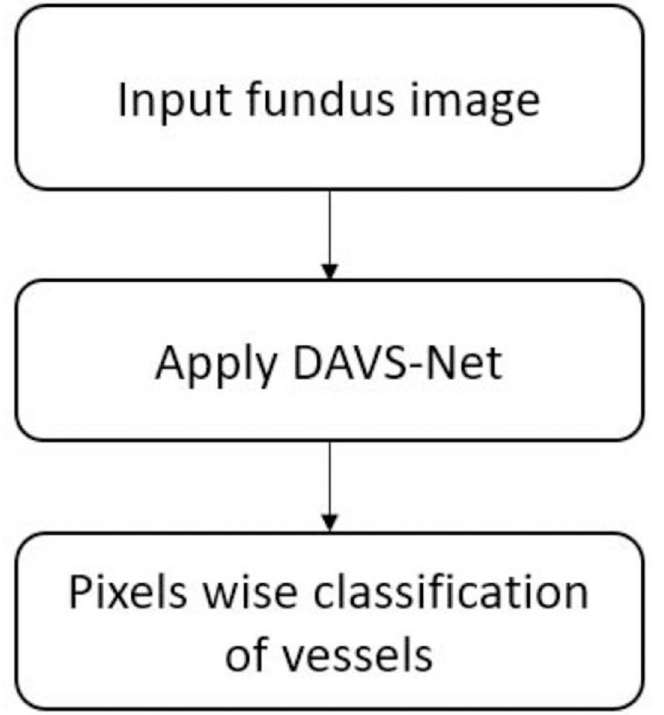
Fig 1. Flow diagram of the proposed